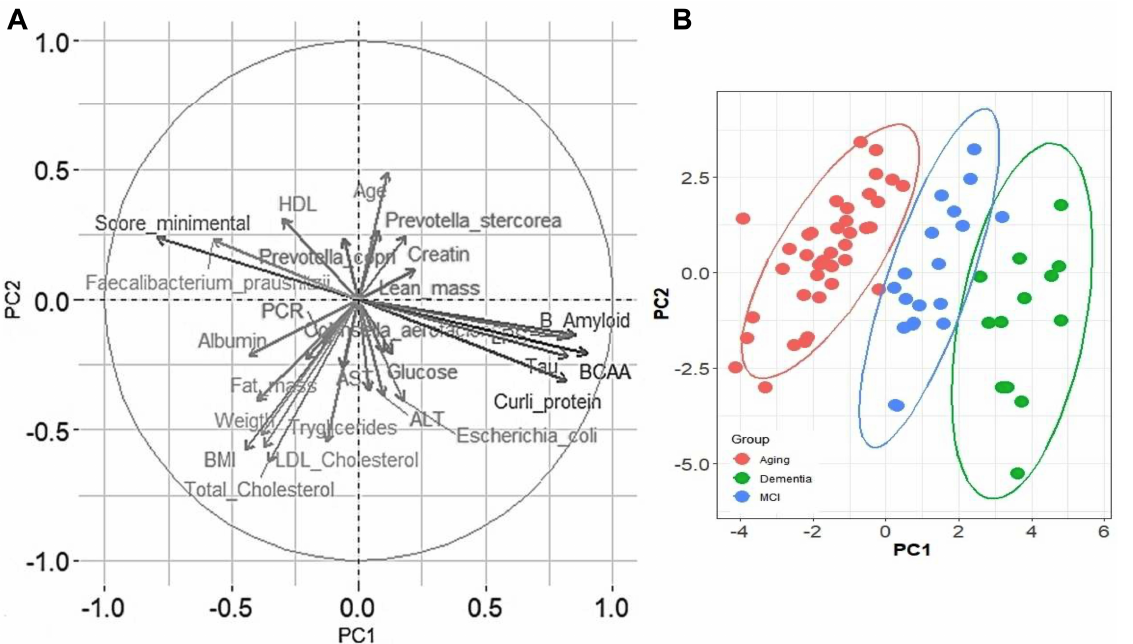
Figure 6. Association among biochemical parameters, gut microbiota, and cognitive evaluation. Variables associated with the distribution of groups and their contribution to PCA ( A ) Distribution of older adults according to their cognitive classification in the principal component analysis ( B ).